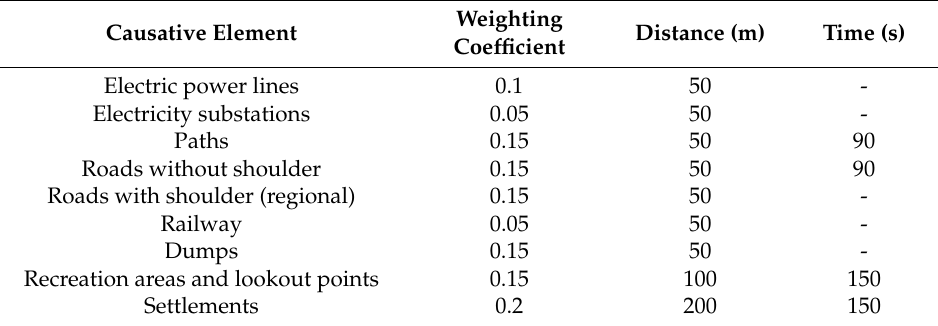
Table 6. Causative elements (induced